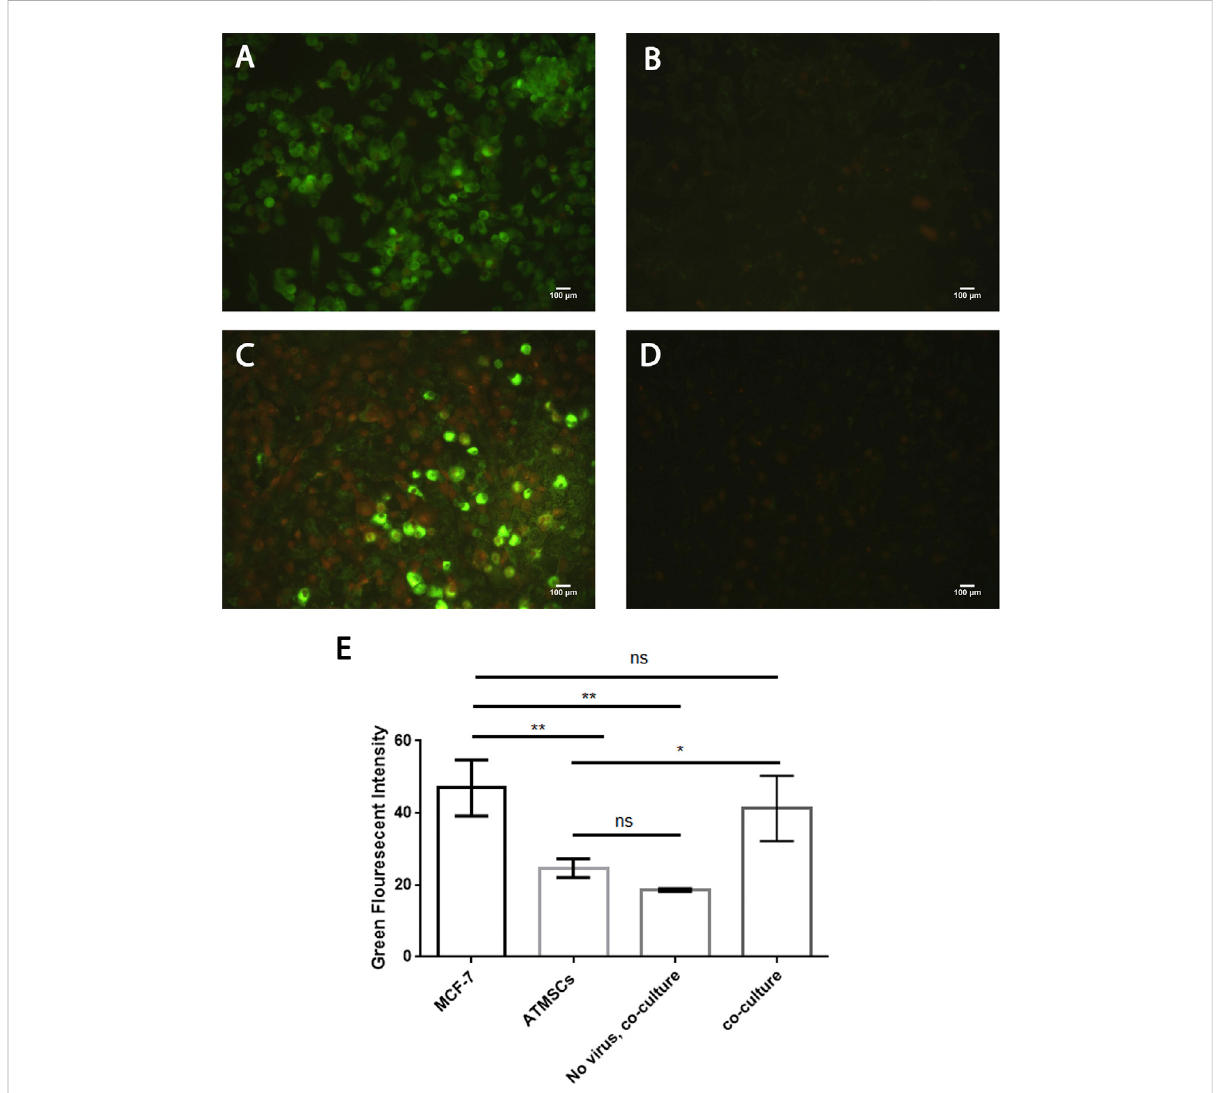
Newcastle disease virus infects and replicates in MCF7 breast cancer cells while infecting but not replicating in normal hATMSCs. (A) MCF7breastcancercellsinfectedwithlabeledNDV. (B) HumannormalstemcellsinfectedwithlabeledNDV. (C) CocultureofMCF7cancercellswith normalhumanstemcellsinfectedwithlabeledNDV. (D) CoculturemodelstainedwithPHK67dyeshowinghardlydetectablegreen fl uorescence. (E) The quantitative image analysis for green fl uorescence by ImageJ con fi rmed signi fi cant green fl uorescence intensity of the infected cancer cells as compared to normal infected cells and the noninfected coculture cell model. There was no signi fi cant difference in the green fl uorescence intensity seen between the infected cancer cells and the infected cocultured cells. Propidium iodide was used as the